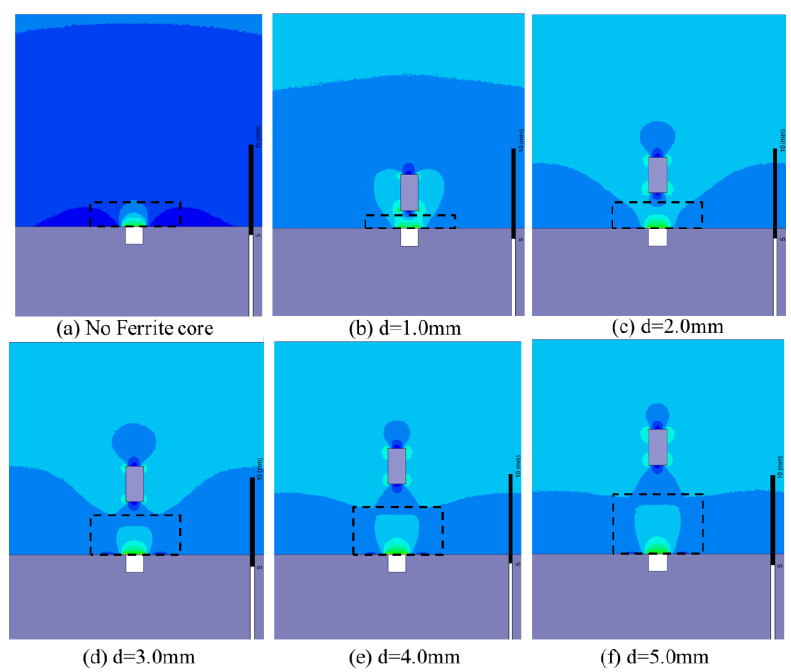
Figure 5. The distributions of the MFL affected by the ferrite core at different lift-off distances.